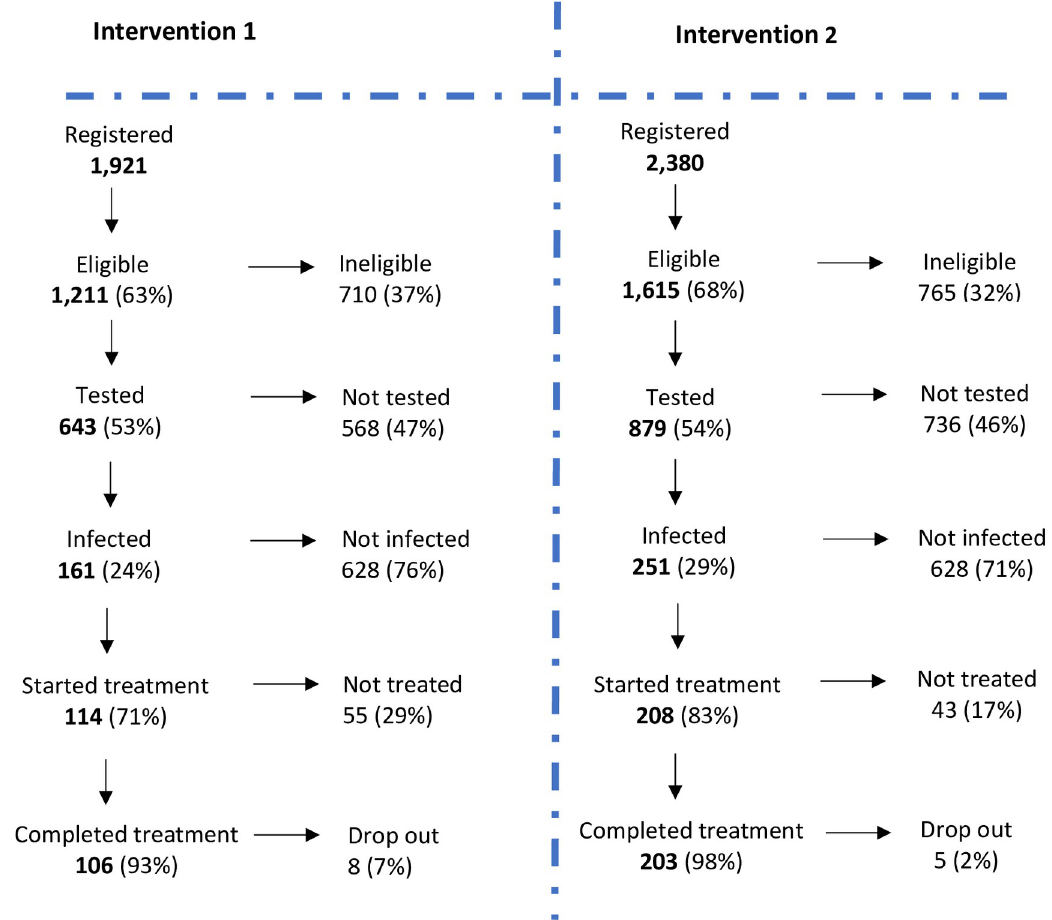
Fig 2. Flow chart from registration to treatment for interventions 1 and 2. Eligible criteria for skin snip test: > 8 years, not pregnant, not breastfeeding, not severely ill; people not tested did not attend testing site, were absence or refused; drop out refers to those who started the treatment and did not complete; During intervention 1, 55 infected individuals did not start treatment among which 19 were underage ( < 9 years), 12 moved away; during intervention 2, 22 pregnant/breastfeeding women and 13 underage < 9 years were excluded from treatment; 8 moved away after testing; during intervention 1; 1 person stop treatment because of side effects, 7 individuals moved away. During intervention 2, 5 persons moved away after starting treatment.